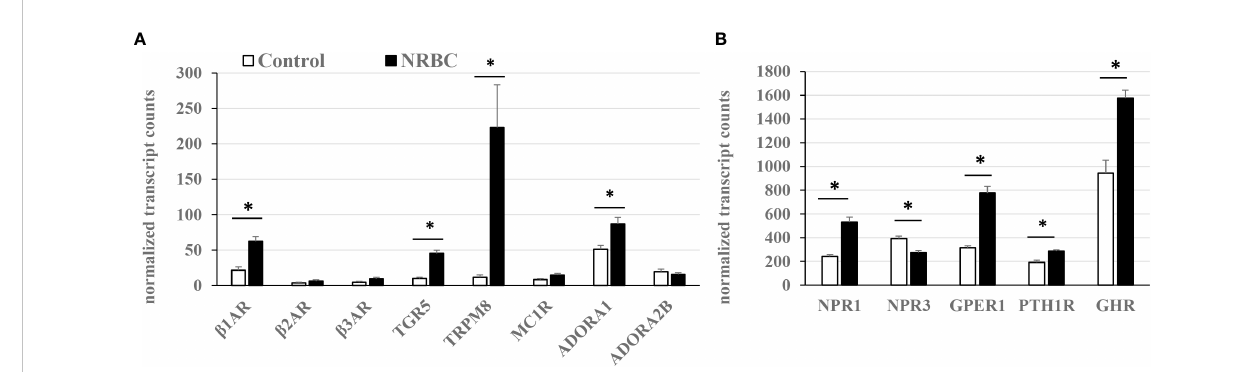
FIGURE 6 Relative receptor levels in white adipocytes (untreated) and NRBC-treated cells. (A) Low abundance (B) High abundance. Adipocytes from two donors with obesity were treated with cell medium (Control) or NRBC for seven days and transcript sequencing analysis was conducted. Data are expressed as mean normalized transcript counts (DEseq2). * indicates Padj< 0.002 for Control vs NRBC. b -adrenergic receptors ( b 1AR, b 2AR, b 3AR), G-protein coupled bile acid receptor (TGR5), Transient receptor potential cation channel subfamily M member 8 (TRPM8), Melanocortin-1 receptor (MC1R), Adenosine receptors A1 and A2B (ADORA1, ADORA2B), Natriuretic peptide receptors (NPR1, NPR3), G-protein coupled estrogen receptor 1 (GPER1), Parathyroid hormone receptor 1 (PTHR1), Growth hormone receptor